Question: Name the type of graph shown.
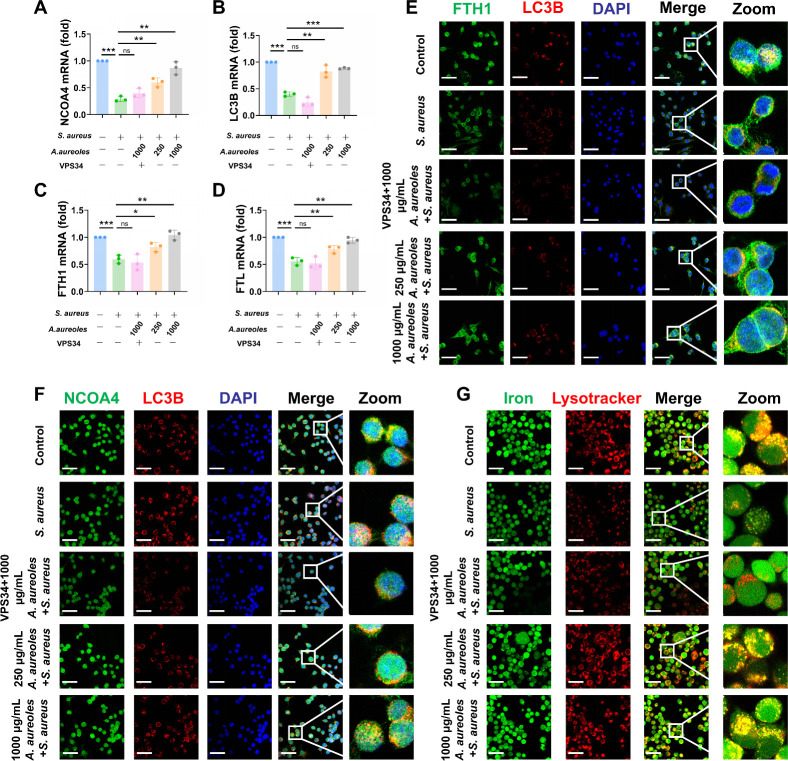
Answer: bar